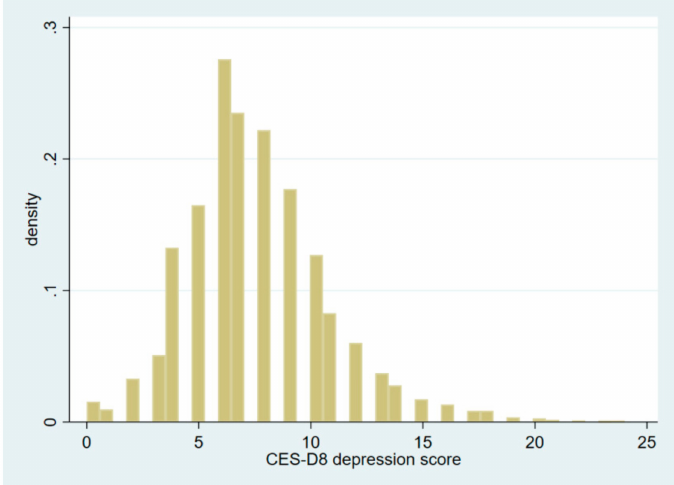
Figure 1. The distributions of CES-D8 depression scores among rural Chinese